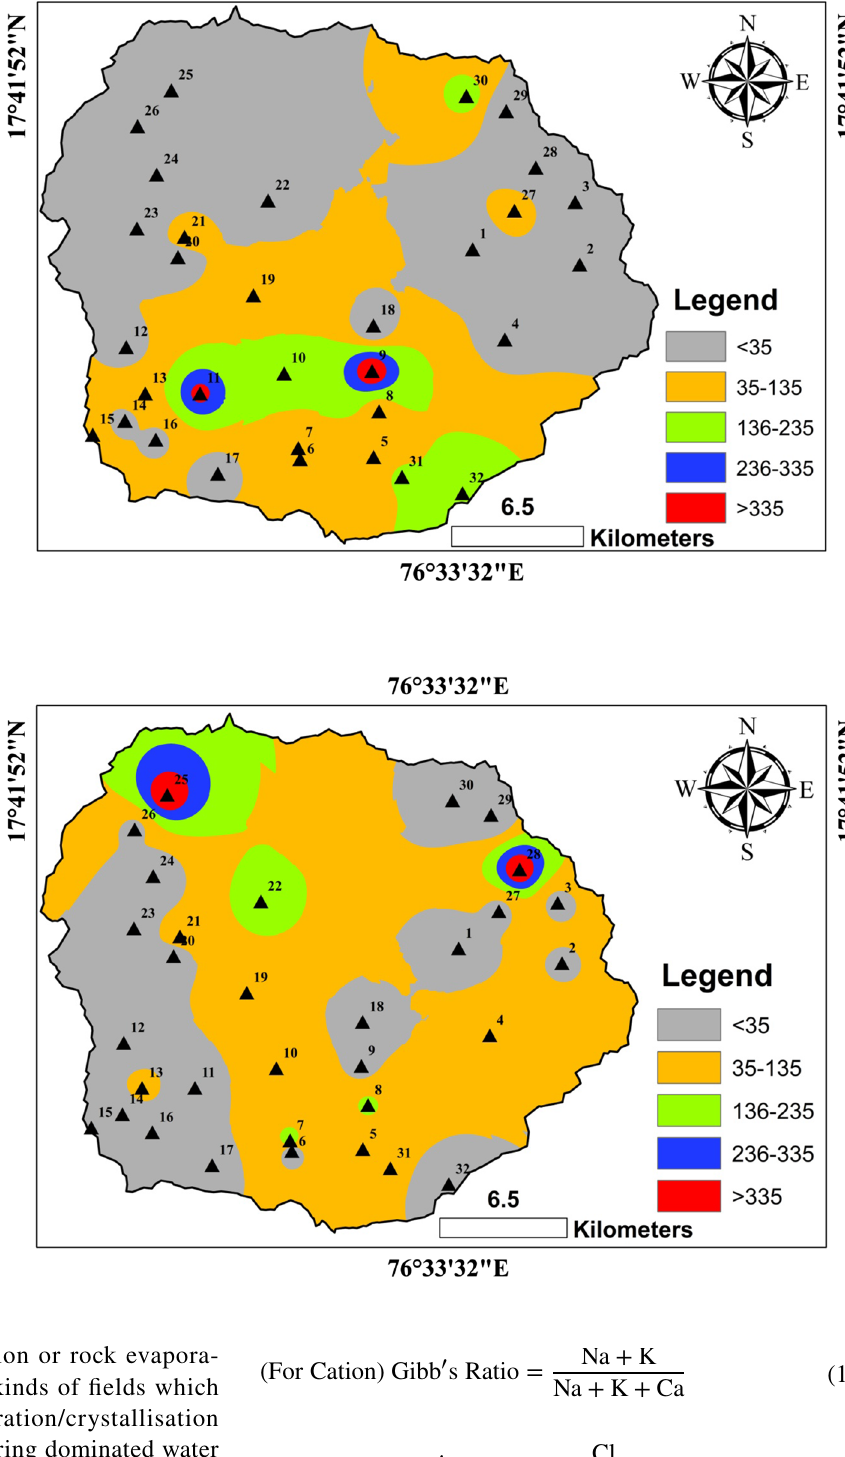
Fig. 22 Geospatial distribution of chloride (pre-monsoon)